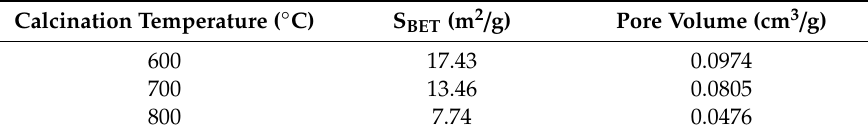
Table 1. Textural property of the NMC412 catalyst at di ff erent calcination temperatures.